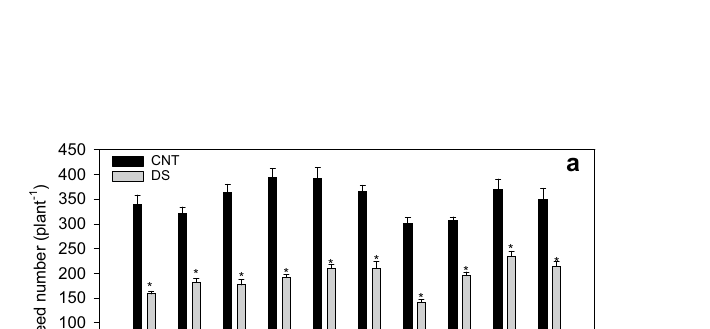
Figure 4. Normalized difference red edge index (NDRE, a ) transformed chlorophyll absorption in reflectance index (TCARI, b ), photochemical reflectance index (PRI, c ), and visible atmospherically resistant index (VARI, d) under control (CNT) and drought stress (DS). *indicates significant difference between treatments for the given cultivar at p < 0.05.